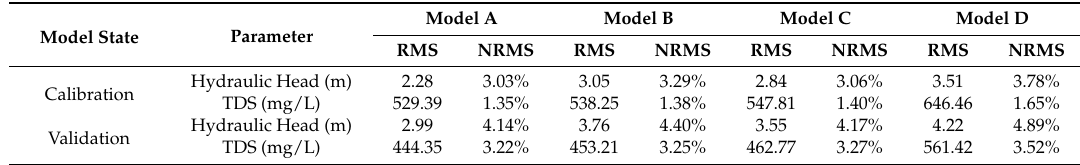
Table 4. Model performance during calibration and